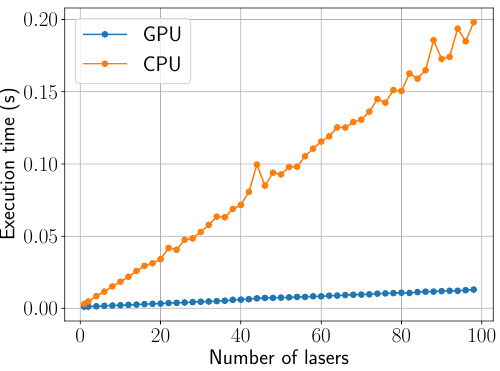
Figure 9. Comparison of CPU and GPU execution times (s) for the computation of 512 coefficients as the number of lasers